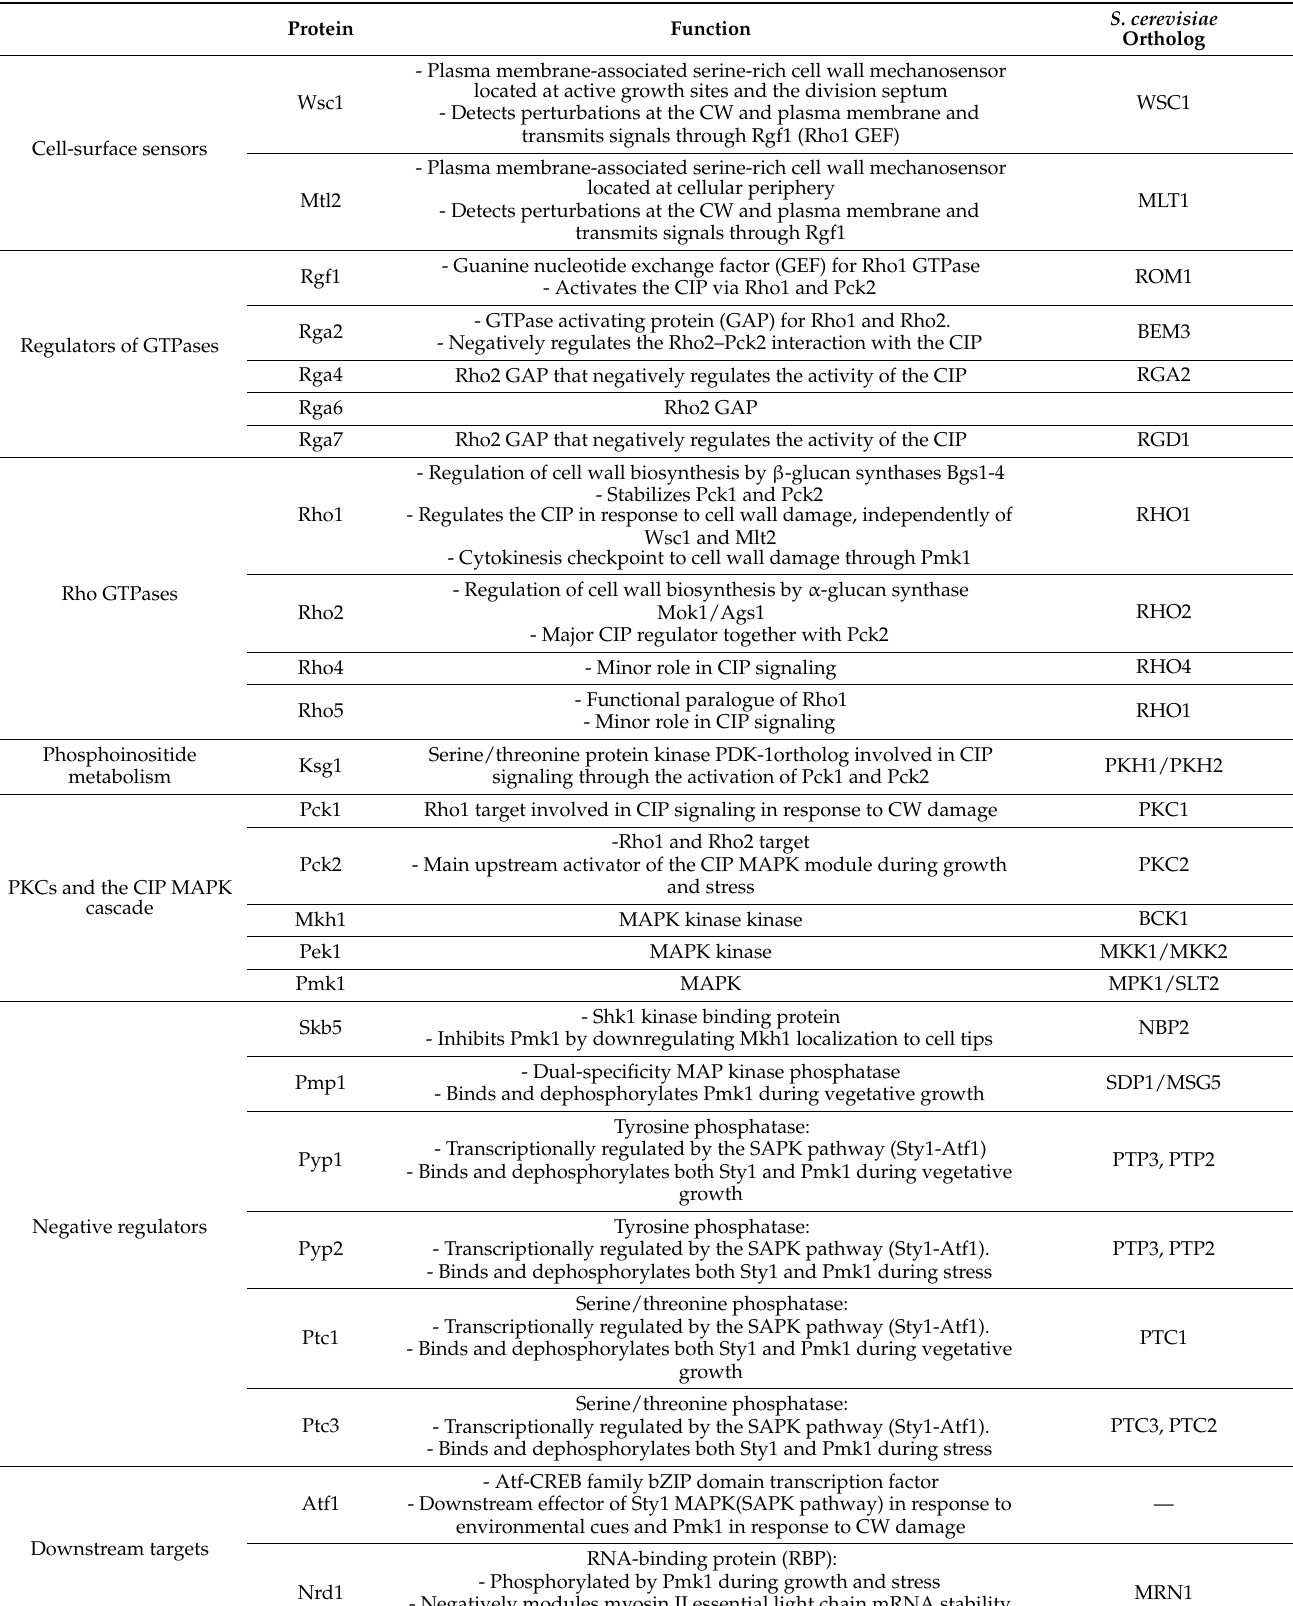
Table 1. Main functional roles of fission yeast CIP components.